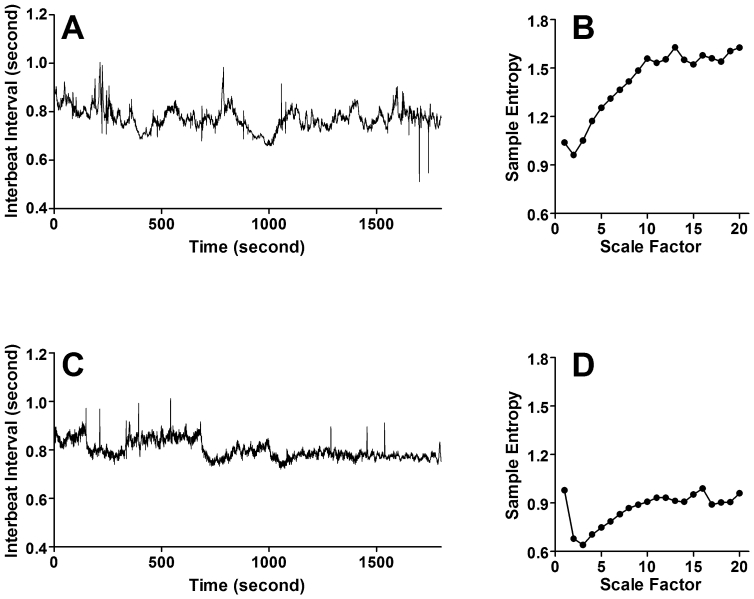
A comparison of a representative interbeat interval time series and analysis of multiscale entropy (MSE) between an APOE ε4-negative subject (top panels) and an APOE ε4-positive subject (bottom panels).Time series length is 30 minutes. The APOE ε4-negative subject showed multiscale organizations in fluctuations of interbeat intervals, whereas a relatively monotonic oscillation was seen in the interbeat interval time series obtained from an APOE ε4-positive subject. By considering the impact of scale on entropy calculations, the sample entropy values for the APOE ε4-negative subject is higher than that for the APOE ε4-positive subject for scales larger than two. Of note, the sum of MSE from scale factor 1 to 20 was 28.3 for the APOE ε4-negative subject and 17.3 for the APOE ε4-positive subject.